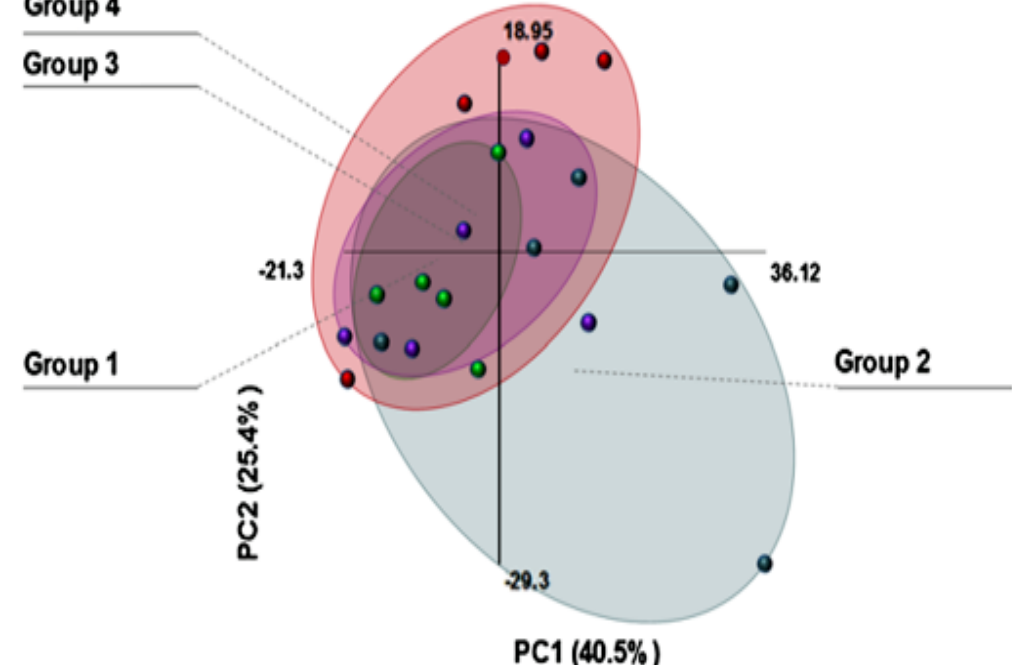
Figure 6. Scores plot of PCA analysis of NIR spectra acquired from individuals with varied moisturizing patterns. (Group 1) daily, (Group 2) none, (Group 3) daily & dry skin, and (Group 4) random. Vairability indicated by size of oval grouping